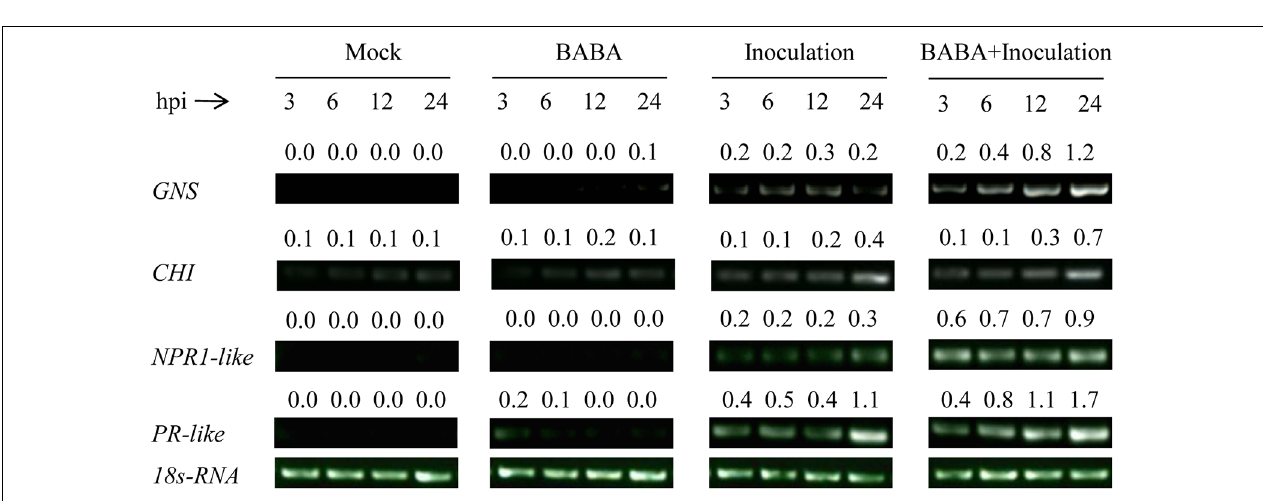
FIGURE 5 | Changes in activities of Ca 2 + -ATPase (A) , cytochrome c oxidase (CCO) (B) , H + -ATPase (C) , and succinate dehydrogenase (SDH) (D) in peach fruit inoculated with Rhizopus stolonifer (Inoculation) or pretreated with 50 mM BABA and then inoculated with R. stolonifer (BABA + Inoculation) during storage at 20 ◦ C. Data are expressed as the mean of triplicate samples. Vertical bars represent the standard errors of the means. Letters without the same letter above the bars indicate significant differences at P < 0.05.